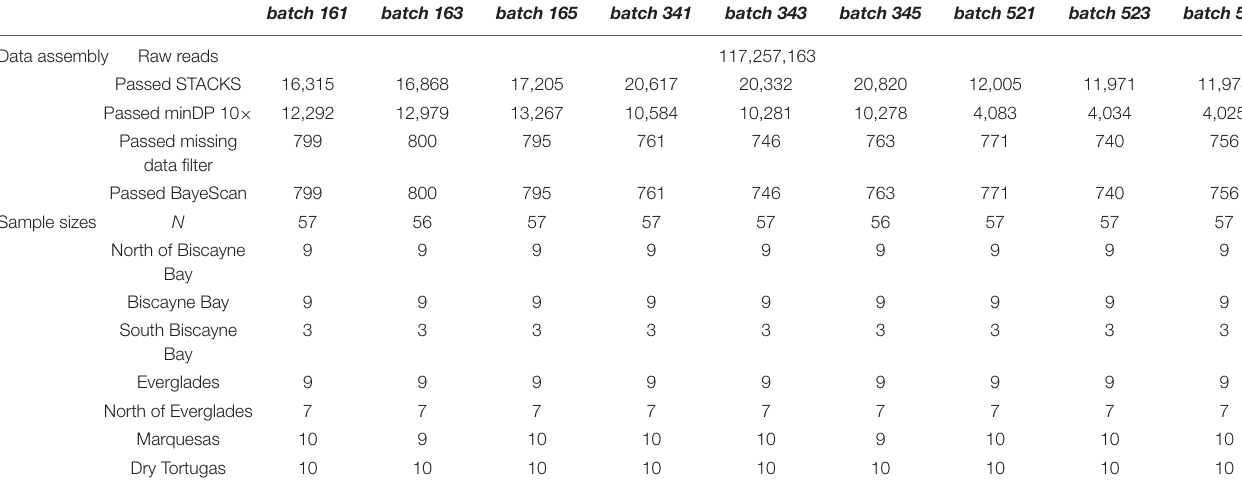
TABLE 2 | Details of the assembled and quality-filtered ddRADseq datasets are